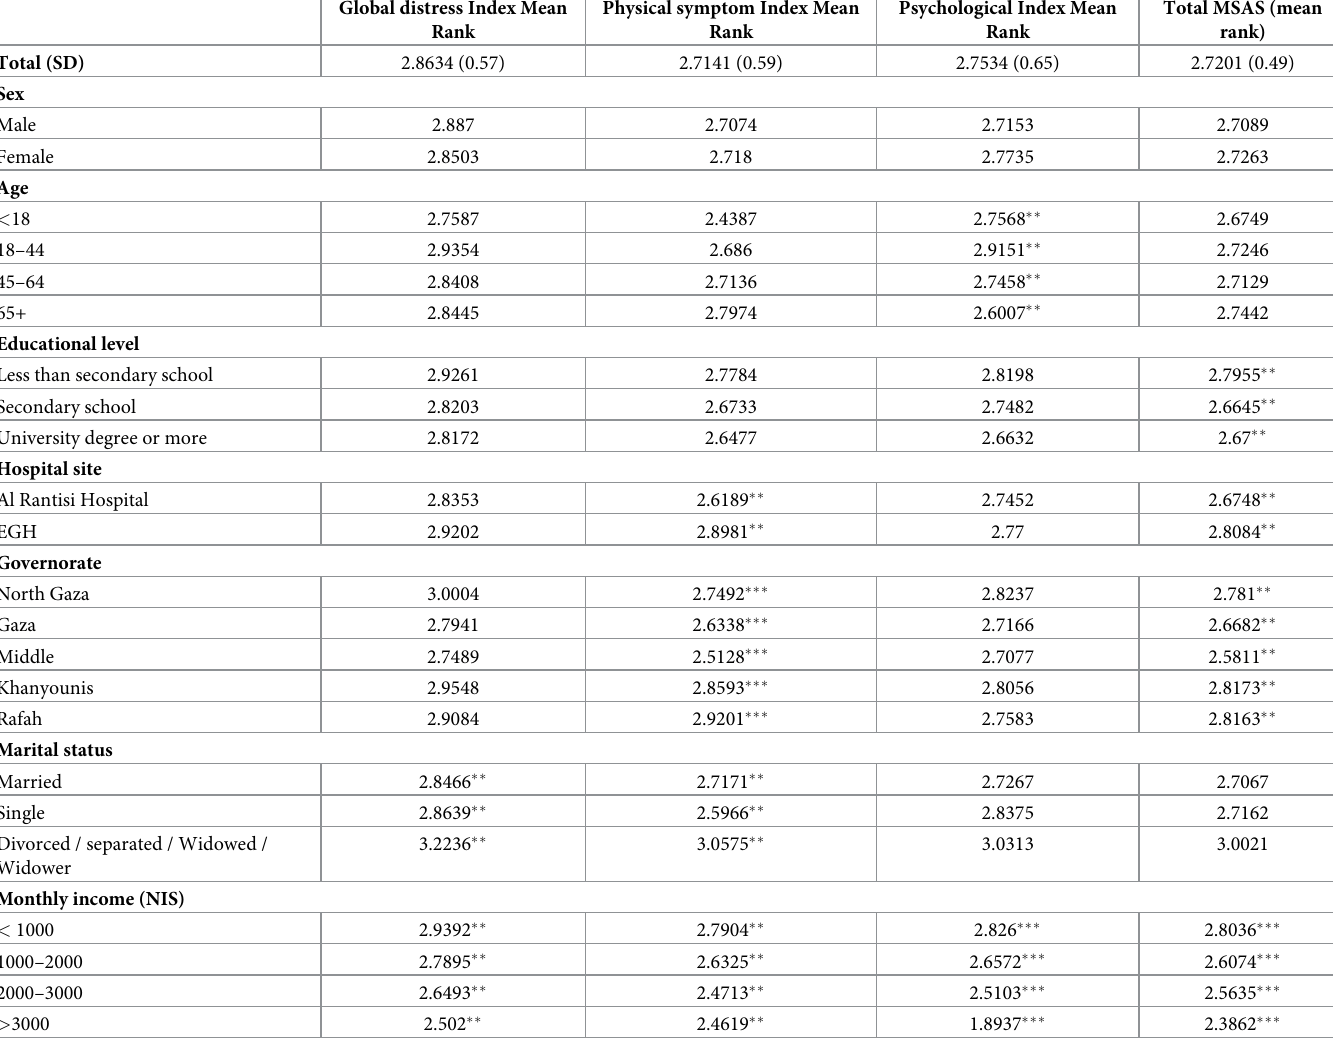
Table 3. Socio-demographic characteristics and related symptom distress reported by